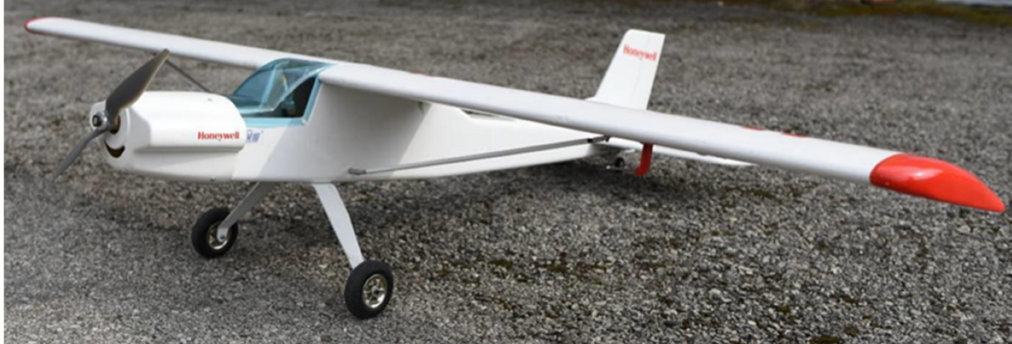
Figure 4. “SkyDog” fixed wing